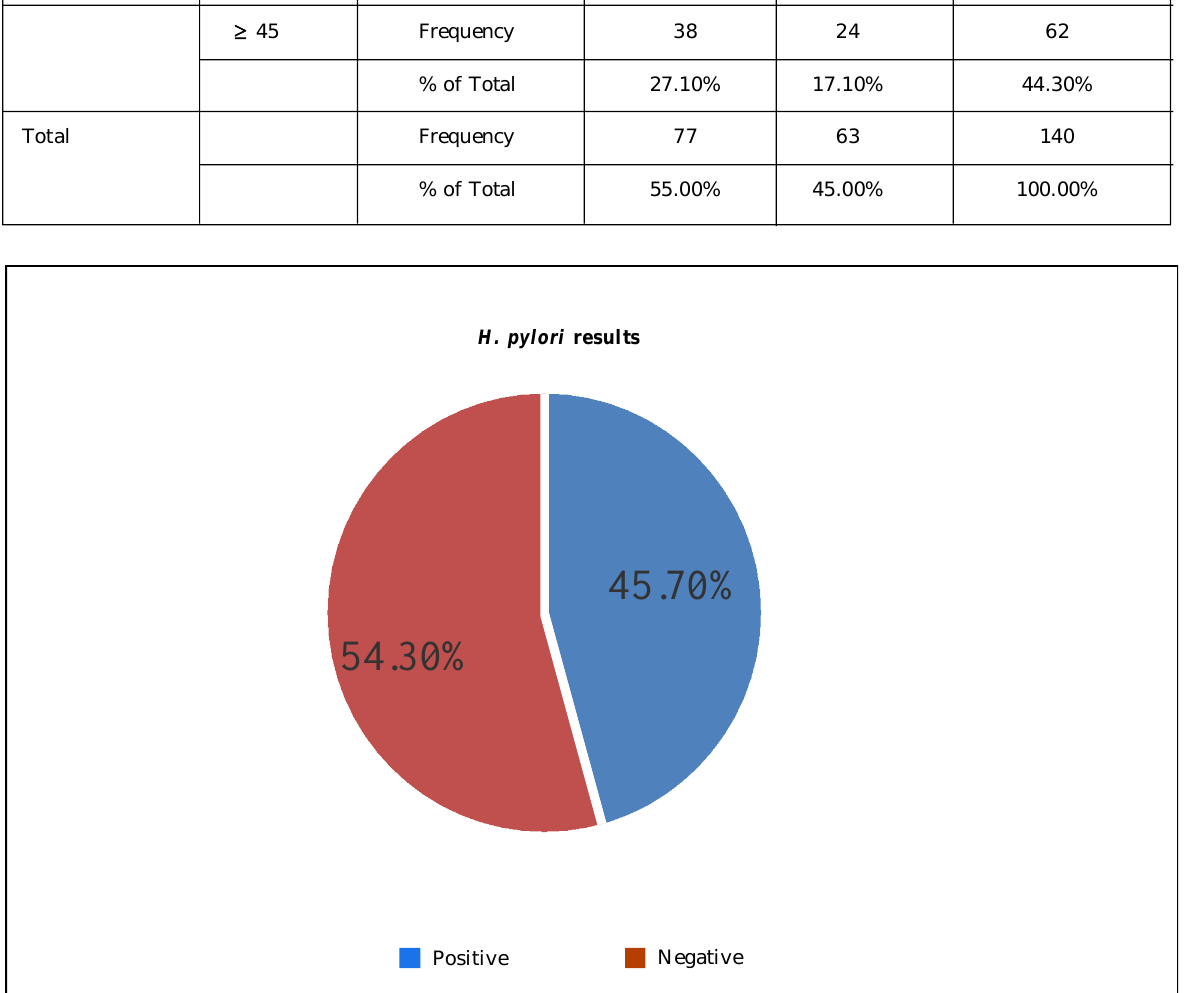
Figure 1: The prevalence of H. pylori in all individuals with